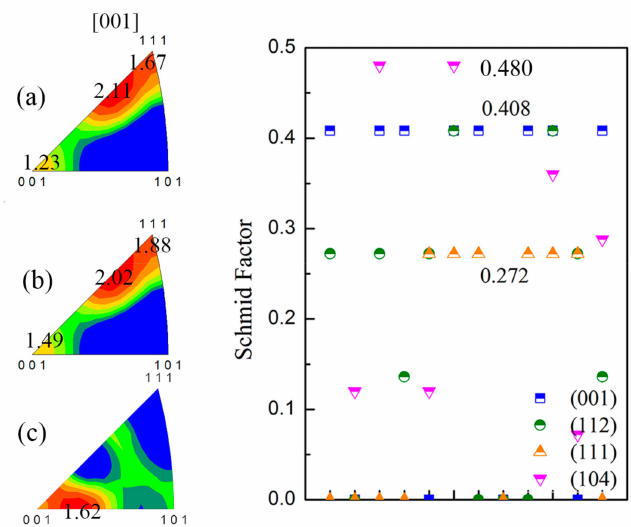
Figure 7. Inverse pole figure of RD direction and corresponding Schmid factor of Al–10Mg alloy along